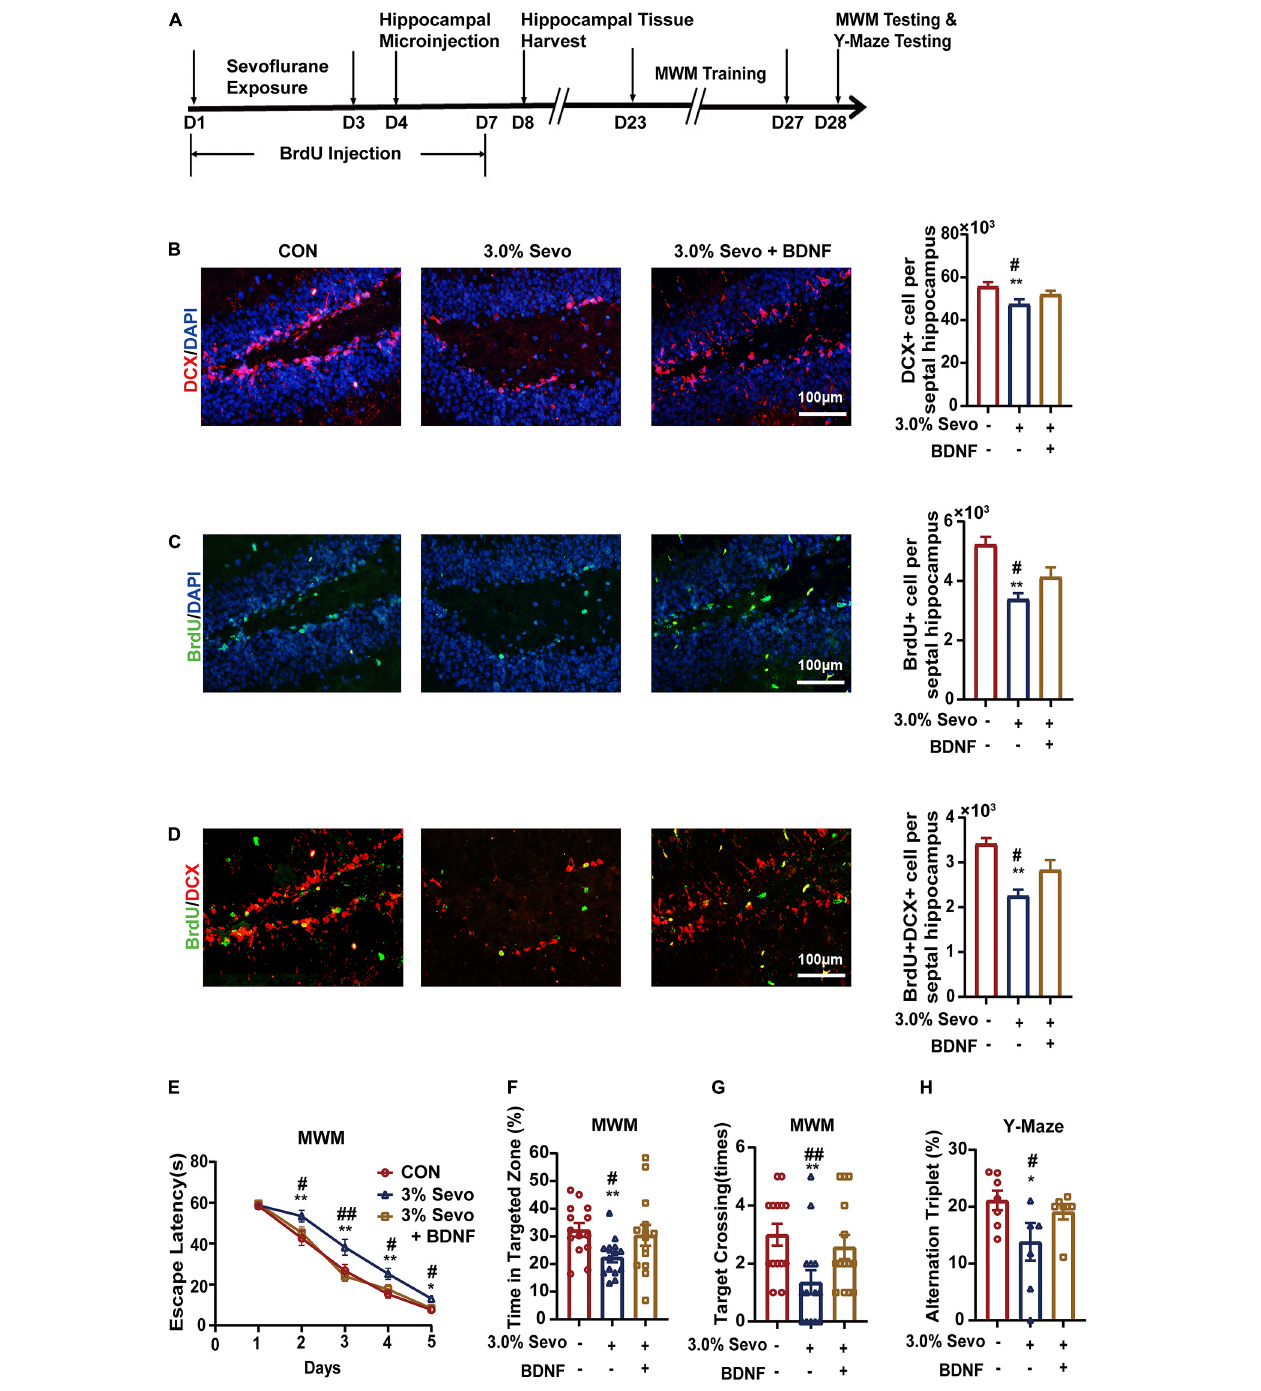
FIGURE 7 | Cognitive impairment and inhibition of AHN induced by 3% sevoflurane in aged mice could be partially prevented by BDNF. (A) Timeline of hippocampal microinjection procedure. (B) Representative immunofluorescence images and quantitative analysis of DCX+ cells in aged mice. (C) Representative immunofluorescence images and quantitative analysis of BrdU+ cells in aged mice. (D) Representative immunofluorescence images and quantitative analysis of BrdU+DCX+ cells in aged mice. (E) Escape latency of the MWM during training days. (F) The percentage of time in targeted zone in testing day. (G) Times of target crossing. (H) Alternation triplet of Y-maze. Values are the mean ± S.E.M. * p < 0.05, ** p < 0.01 compared with the CON group. # p < 0.05, ## p < 0.01 compared with the BDNF group ( n = 8/group for immunofluorescence and n = 7/group for behavioral test). D, days of experimental procedure; MWM, Morris Water Maze Test; BrdU, 5-Bromodeoxyuridine; DCX, doublecortin; BDNF, brain-derived neurotrophic factor; TrkB, tyrosine receptor kinase B; NT-3, Neurotrophin-3; TrkC, tyrosine receptor kinase C; CON, control group; 1.5% Sevo, 1.5% sevoflurane group; 3.0% Sevo, 3.0% sevoflurane group.